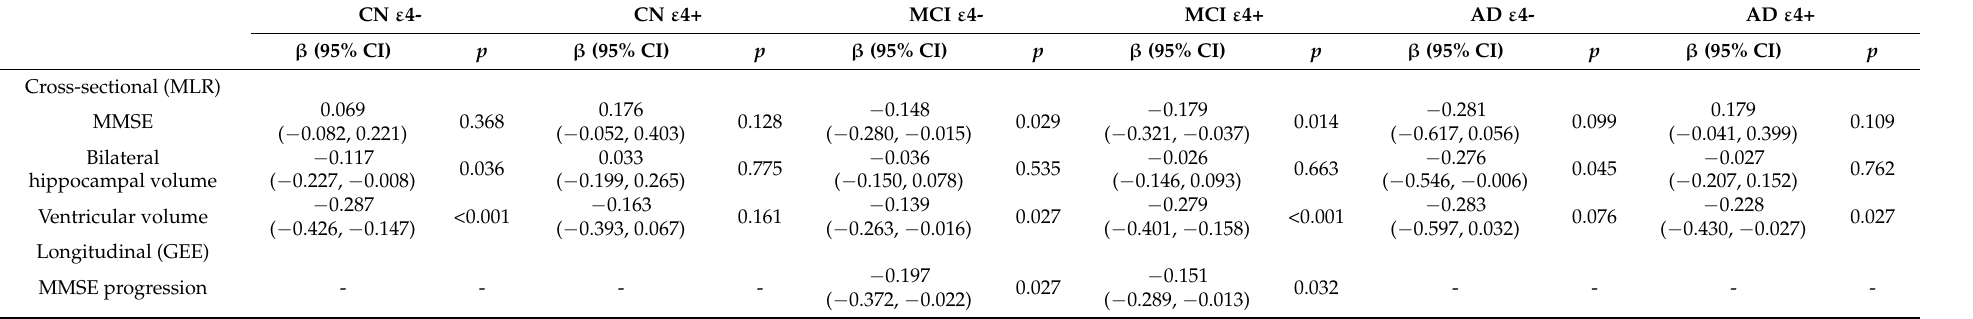
Table 4. Correlations of CSF GAP-43 with cognition, hippocampus volume, and ventricular